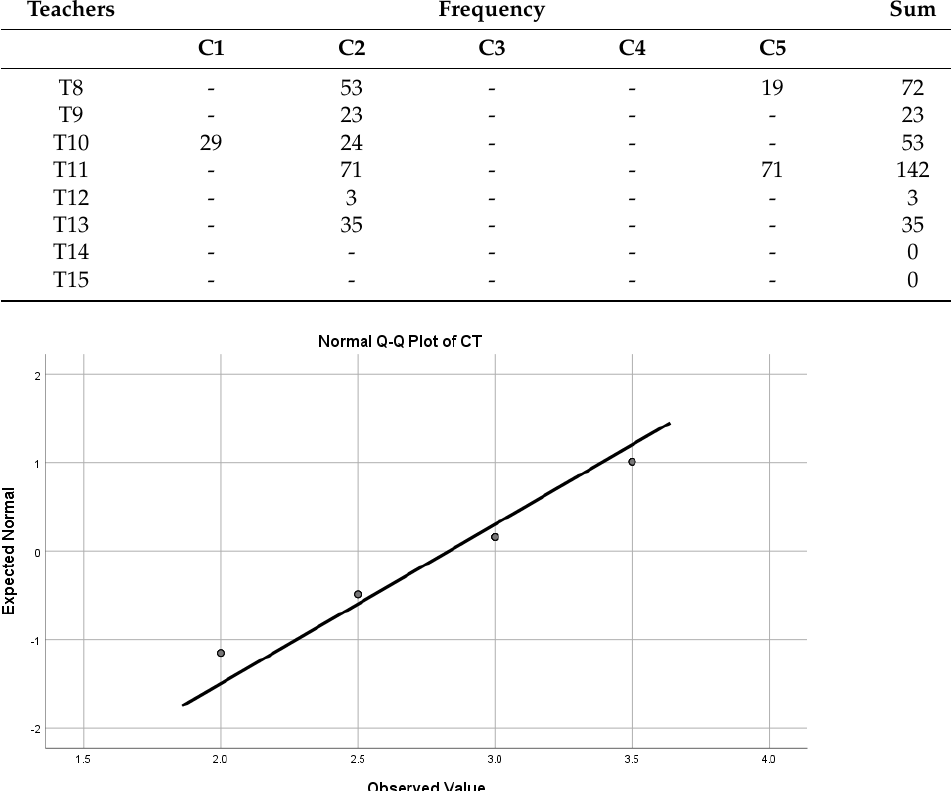
Table 7. Frequency of use of the CT Criteria by teachers in Non-STEM courses.